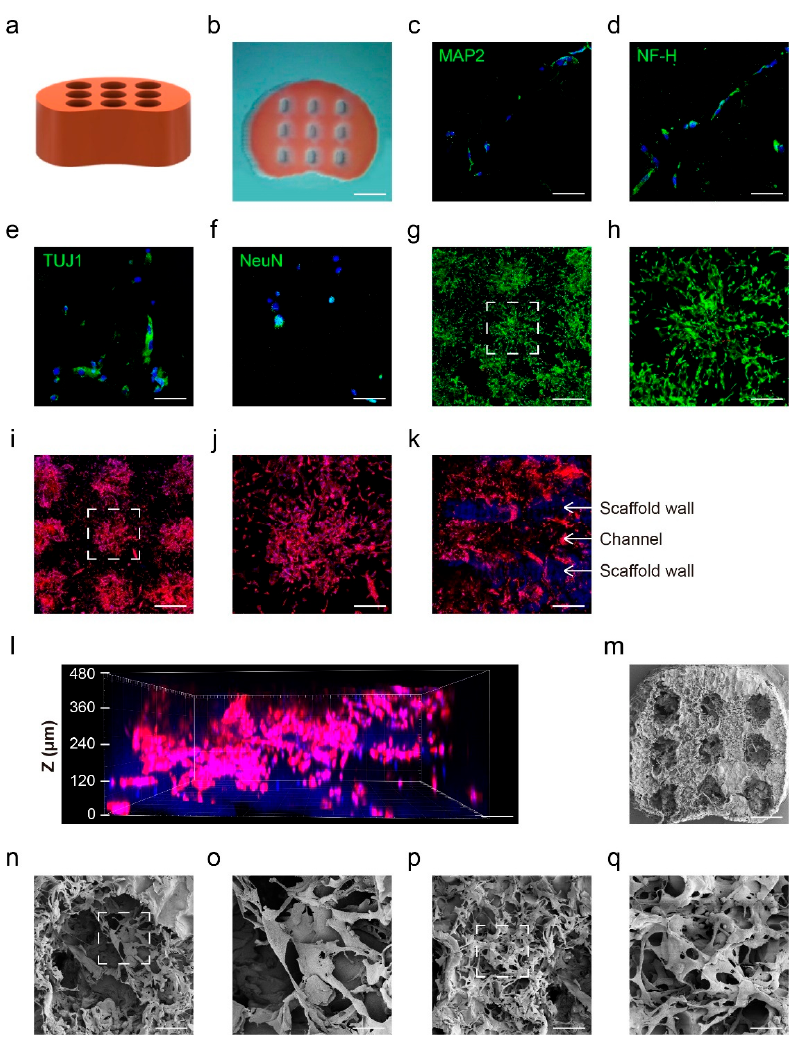
Figure 4. The in vitro performance of hAEC-neural-like cell biomimetic scaffolds. ( a , b ) The design and real product of biomimetic rat spinal cord scaffold; ( c – f ) the immunofluorescence staining of neuron specific markers MAP2, NF-H, TUJ1 and NeuN to the hAEC-neural-like cell biomimetic scaffolds; ( g , h ) the live/dead staining of hAEC-neural-like cells on scaffolds, green fluorescence- represented live cells and red fluorescence-represented dead cells; h is the magnified image of the white dotted frame in g; ( i , j ) the cell skeleton staining of hAEC-neural-like cells on scaffolds observed from the radial direction, red fluorescence-represented cell skeleton, blue fluorescence-represented cell nucleus; j is the magnified image of the white dotted frame in i; ( k ) the cell skeleton staining of hAEC-neural-like cells on scaffolds observed from the axial direction, red fluorescence showed the distribution of cells in channels, blue fluorescence represented the autofluorescence of scaffold walls; ( l ) 3D view of cells distribution in the scaffold channel, red fluorescence represents the cell skeleton, blue fluorescence represents the cell nucleus; ( m – q ) SEM images of hAEC-neural-like cells on scaffolds; ( m ) SEM image of the whole biomimetic scaffold loaded with hAEC-neural-like cells; ( n ) SEM scanning of morphology of cells in micro-channel; ( o ) the magnified image of the white dotted frame in n; ( p ) the cell network formed by hAEC-neural-like cells on the scaffold surface; ( q ) the magnified image of the white dotted frame in p. Scale bars: ( b ): 700 µ m; ( c – f ): 100 µ m; ( g ): 650 µ m; ( h ): 250 µ m; ( i ): 650 µ m; ( j ): 250 µ m; ( k ): 500 µ m; ( l ): 80 µ m; ( m ): 400 µ m; ( n ): 150 µ m; ( o ): 35 µ m; ( p ): 150 µ m; ( q ): 50 µ